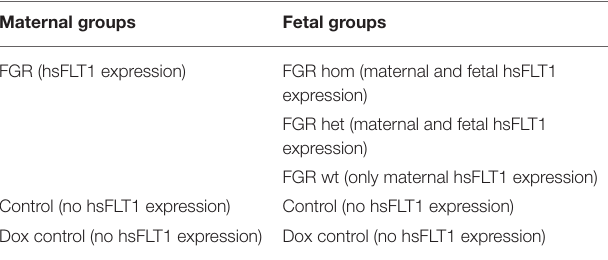
TABLE 1 | Maternal and fetal experimental